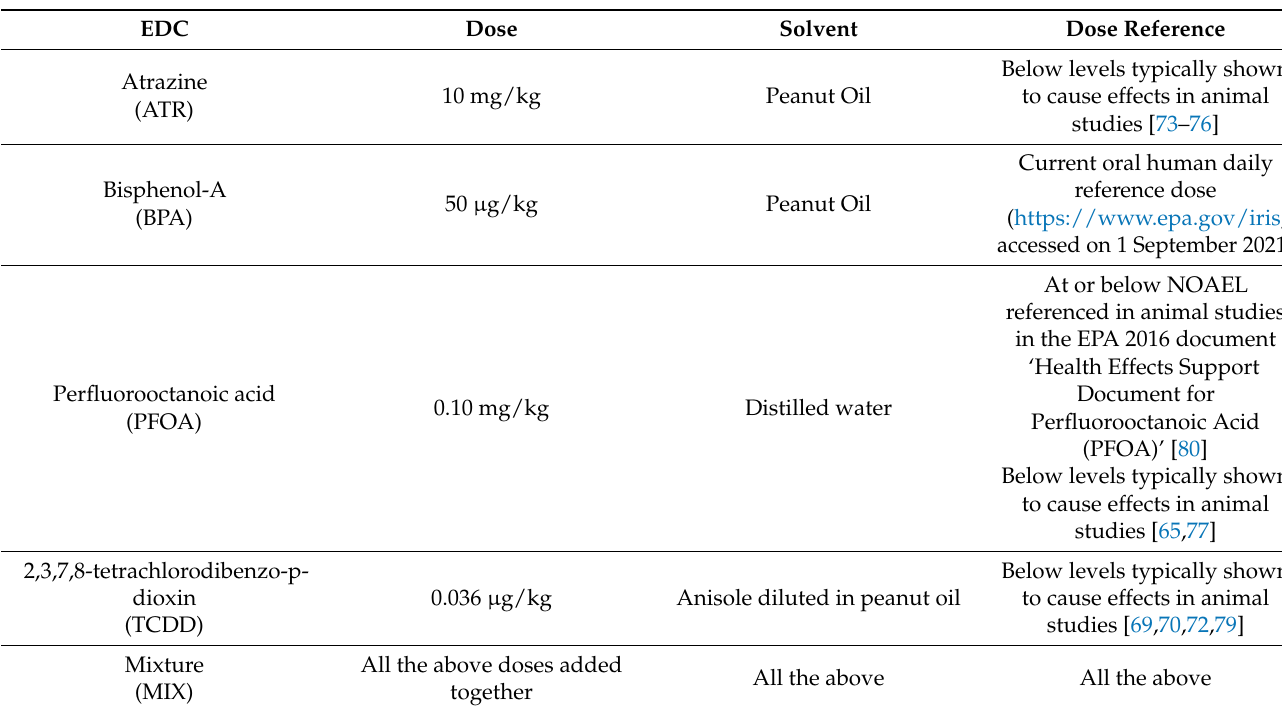
Table 1. EDC Dosing